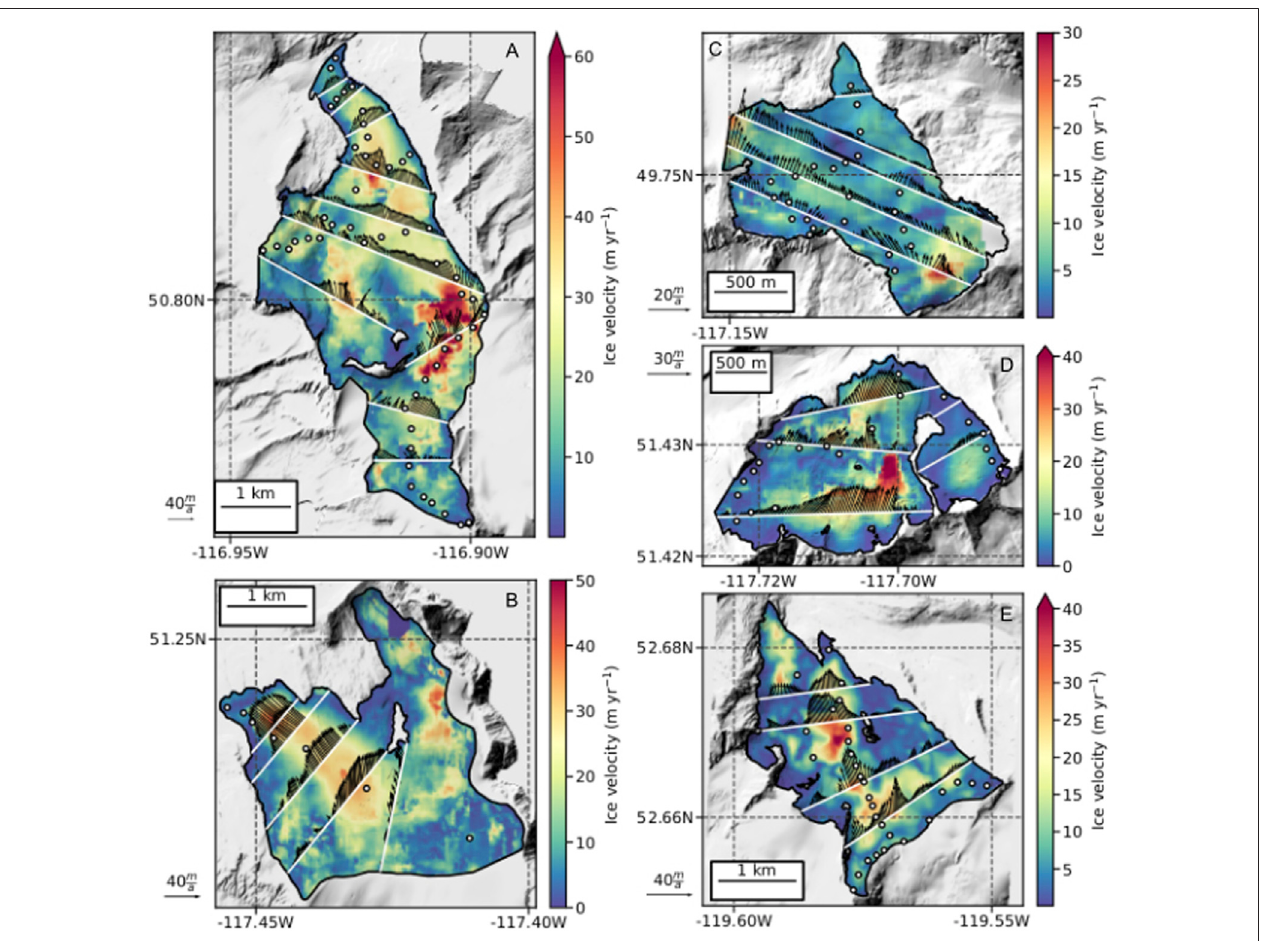
FIGURE 2 | Surface velocity of (A) Conrad, (B) Illecillewaet, (C) Kokanee, (D) Nordic and (E) Zillmer glaciers. Velocity fi elds are 2018 mosaics of individual feature- tracking-derived velocity fi elds ( Table 2 ). Flux gates are white lines and glaciological observations are white dots with black outline. Black arrows depict surface ice velocity vectors at the fl ux gates with variable scaling for